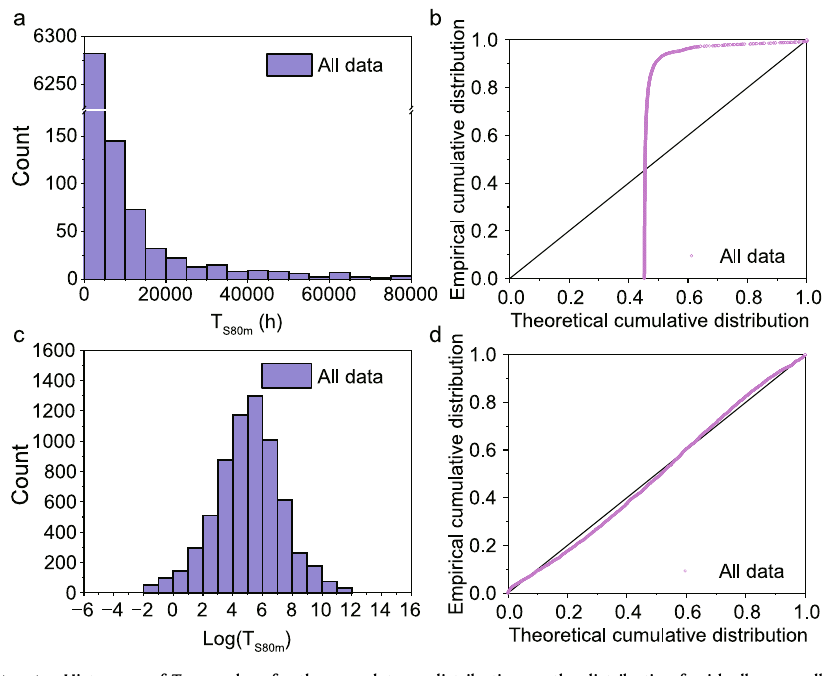
distribution vs. the distribution for ideally normally distributed data. c , d The corresponding fi gures for log( T S80m ) values (log for the natural